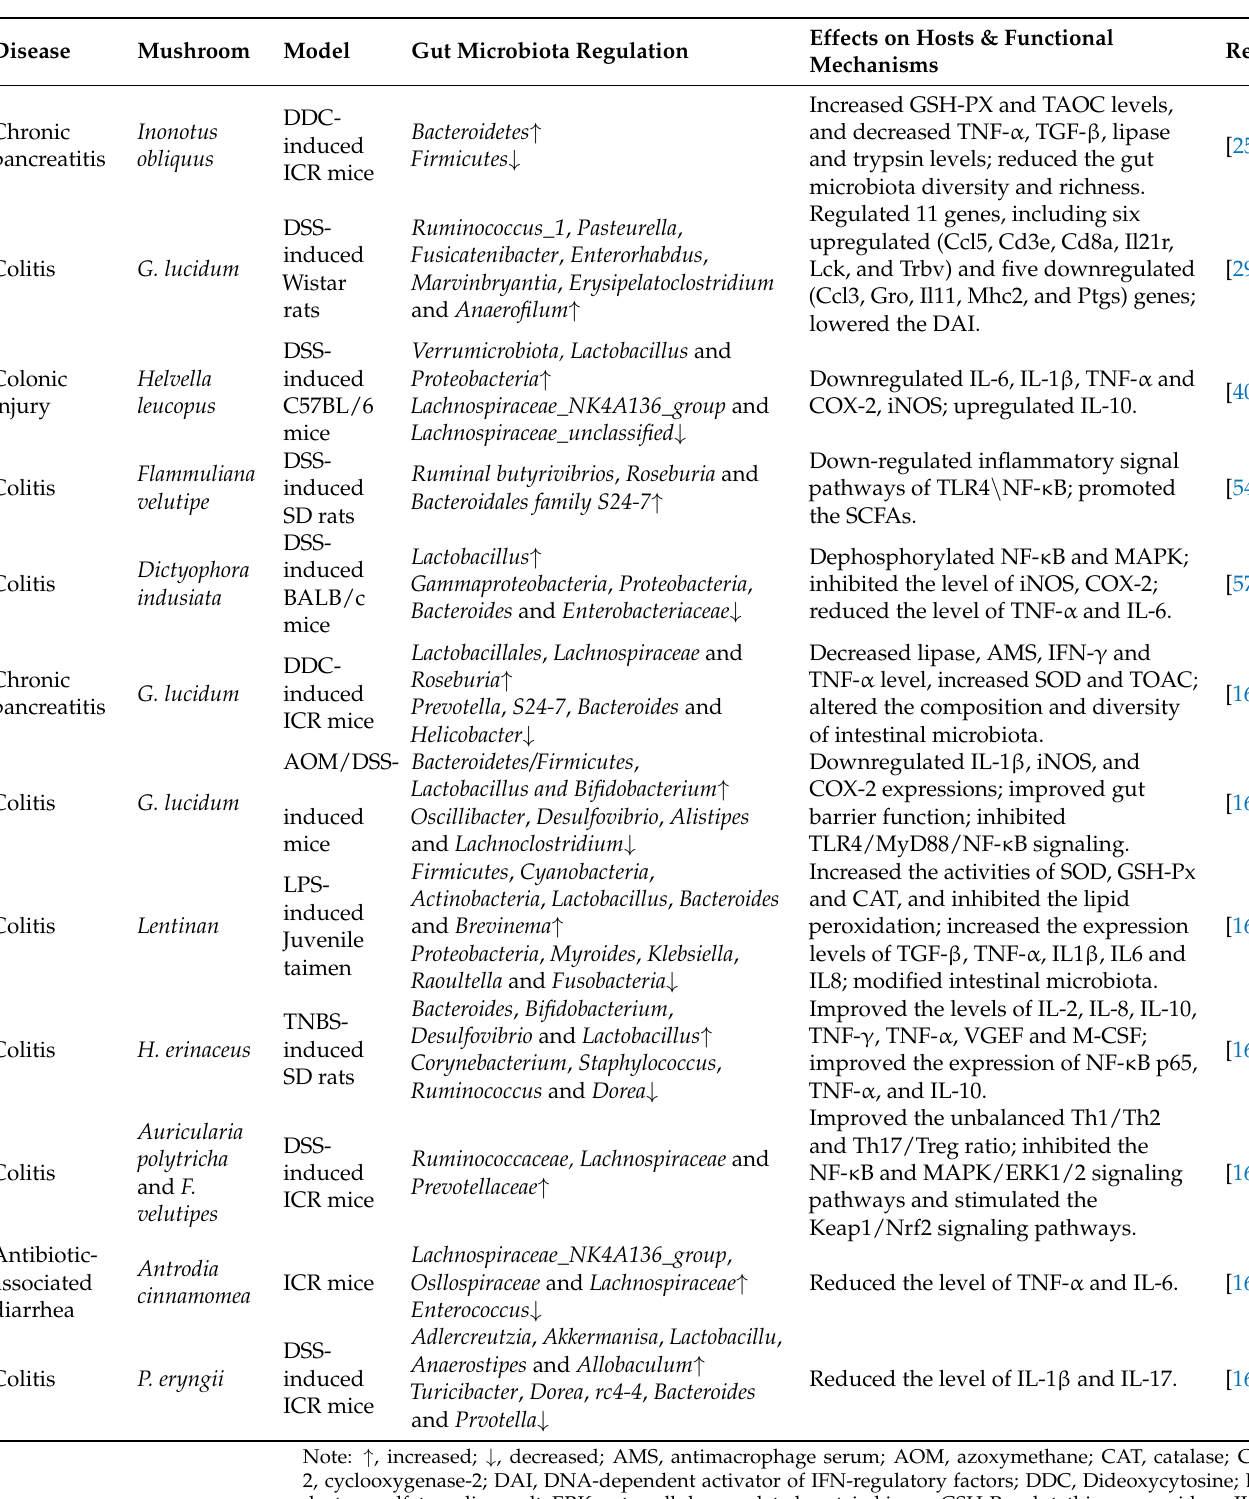
Table 3. The modulation of the gut microbiota in immunological diseases by mushroom